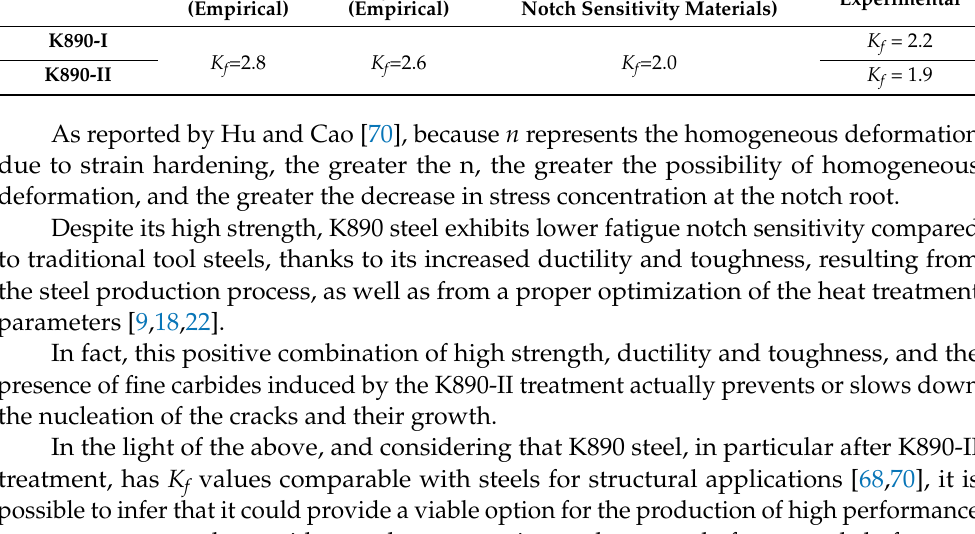
Table 5. Notch factor K f values for the K890-I e K890-II treated steel evaluated by means of empirical (Peterson [72], Heywood [73], Hu and Cao [70]) and experimental relationships. Peterson Heywood (Empirical)